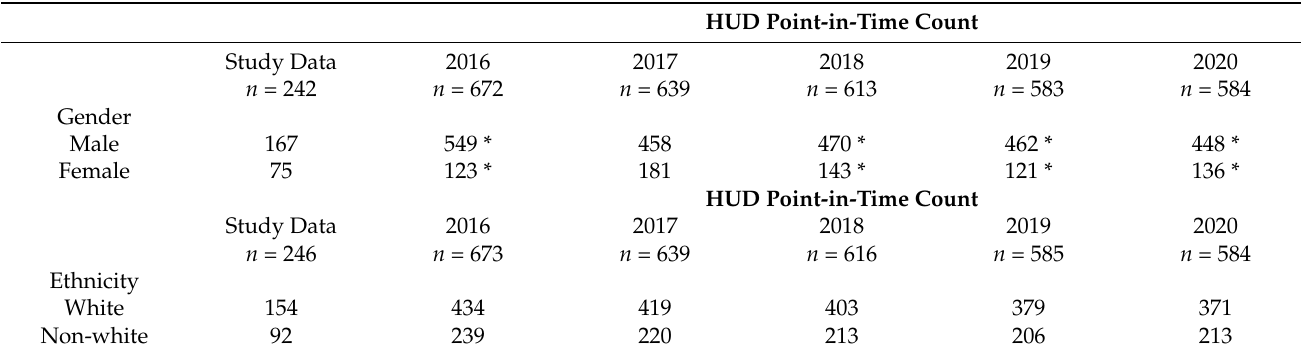
Table 2. Two-tailed proportion z-score comparison between sample demographic proportions and annual PIT count demographic proportions from 2016–2020.